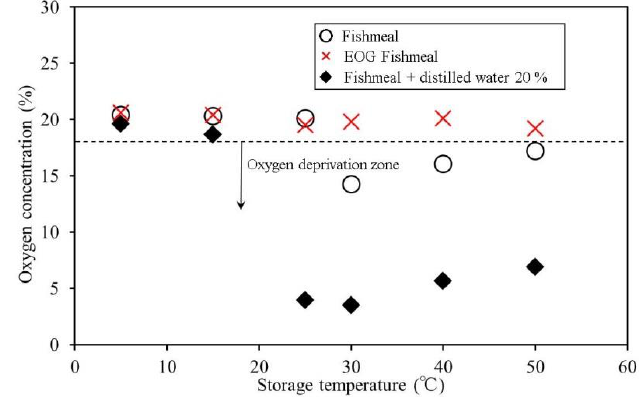
Figure 19. Carbon dioxide concentrations as functions of storage temperature for SSSR samples. Recycling 2018 , 3 , x